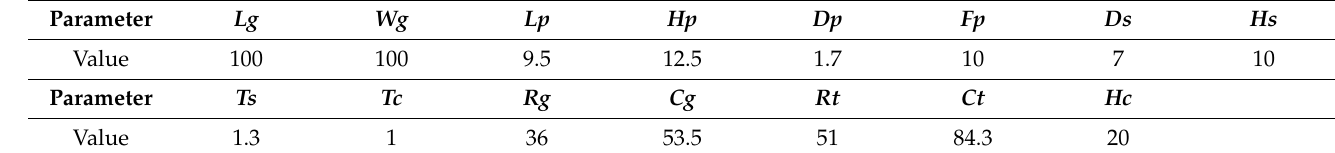
Table 1. Dimension value (mm) of the proposed antenna.